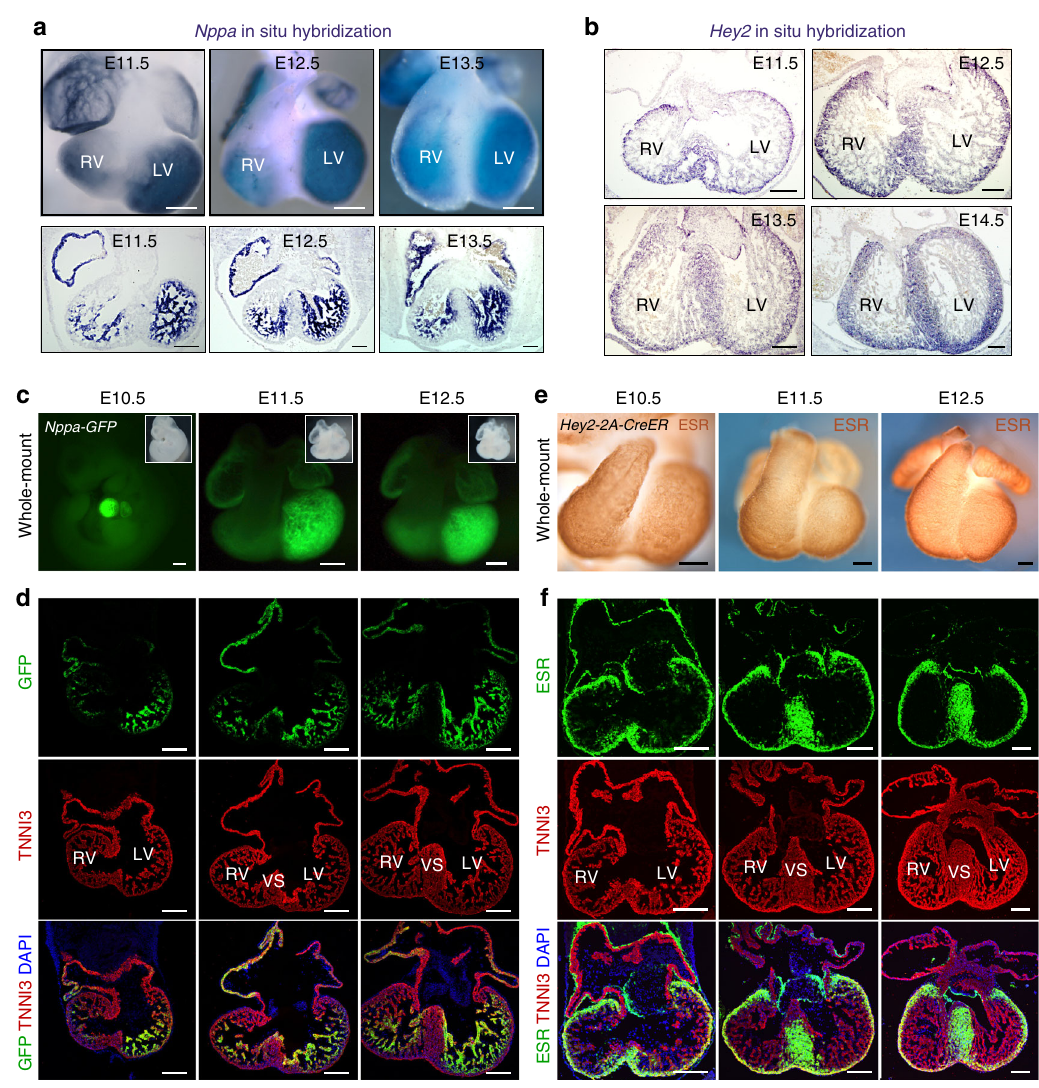
Fig. 1 Nppa and Hey2 are expressed in trabecular and compact myocardium, respectively. a Whole-mount and sectional in situ hybridization of Nppa on E11.5 – E13.5 hearts. b In situ hybridization of Hey2 on E11.5 – E14.5 heart sections. c Whole-mount fl uorescence view of E10.5 – E12.5 Nppa-GFP embryos or hearts. Inserts are bright- fi eld view of embryos or hearts. d Immunostaining for GFP as surrogate for Nppa and cardiomyocyte marker TNNI3 on Nppa-GFP heart sections showed GFP is restricted to trabecular myocardium. e Whole-mount ESR staining of E10.5 – E12.5 Hey2-2A-CreER mice hearts. f Immunostaining for ESR (as surrogate for Hey2) and TNNI3 on Hey2-2A-CreER heart sections showed ESR expression is enriched in compact myocardium but not in atrial or trabecular myocardium. Scale bars, 200 µ m. Magni fi ed images are shown in Supplementary Fig. 3b. Each image is a representative of four individual